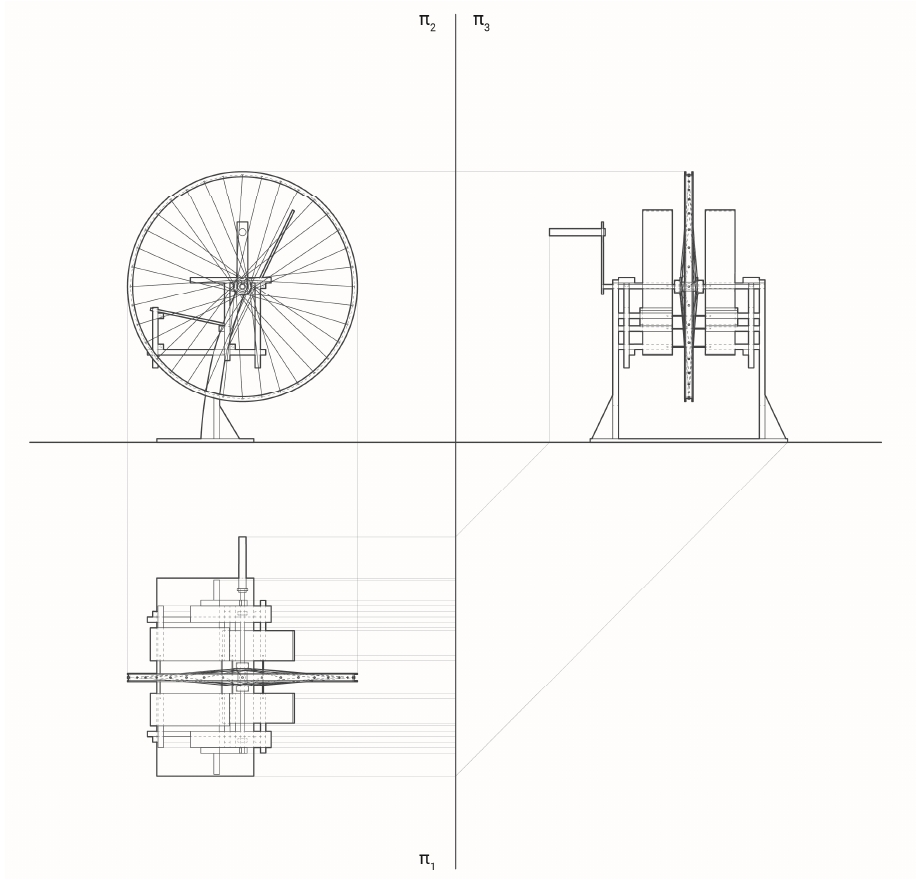
Figure 7. Piera Macedonio, Martina Lucchin: Duchampe and Rietveld